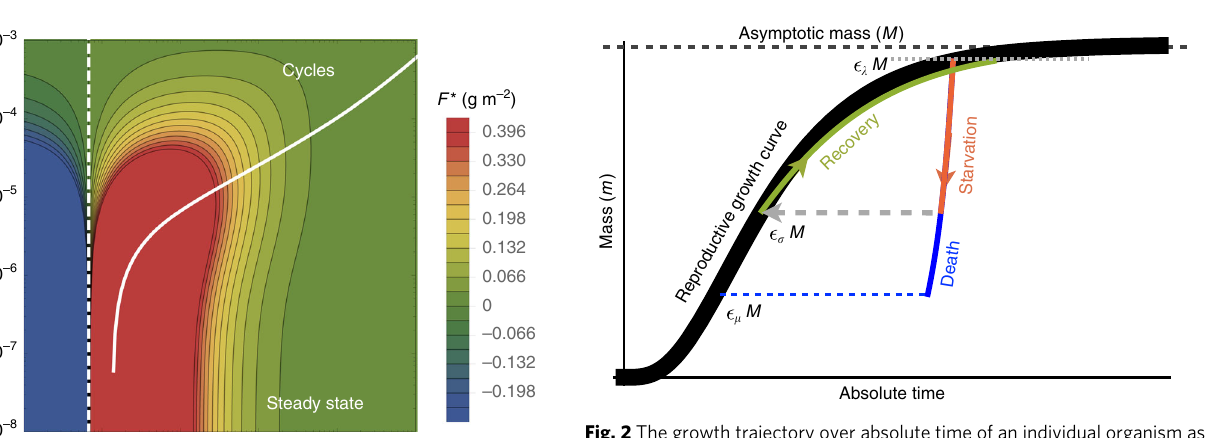
Fig. 2 The growth trajectory over absolute time of an individual organism as a function of body mass. Initial growth follows the black trajectory to an energetically replete reproductive adult mass of m = ε λ M (Methods). Starvation follows the red trajectory to m = ε σ ε λ M . Recovery follows the green curve to the replete adult mass, where this trajectory differs from the original growth because only fat is being regrown that requires a longer time to reach ε λ M . Alternatively, death from starvation follows the blue trajectory to m = ε μ ε λ